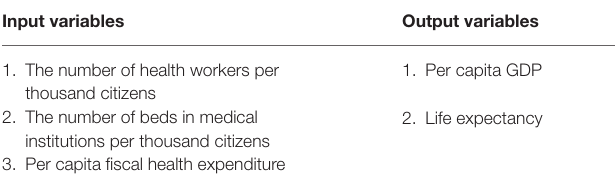
TABLE 1 | Input and output variables.